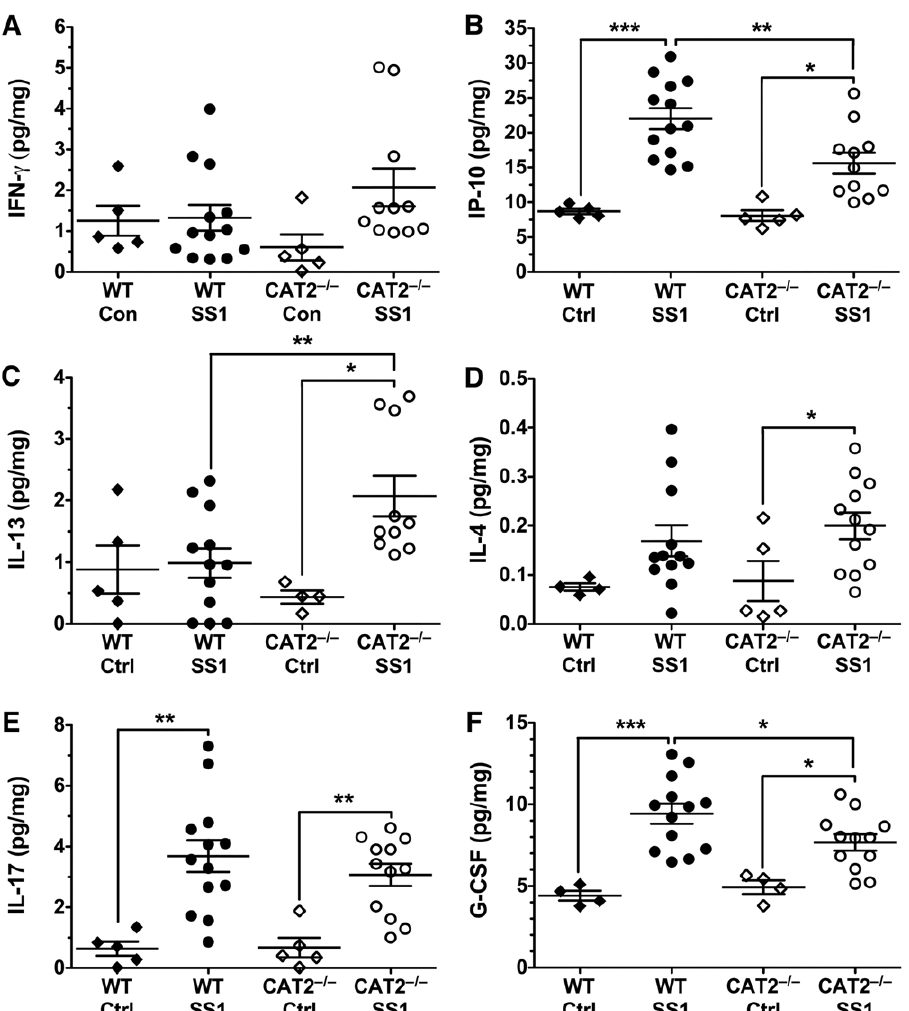
Figure 5. Th2, Th1, and innate response cytokine expression in response to H.pylori infection is altered in CAT2 2 / 2 mice. Protein lysates were analyzed by Luminex for expression levels of other cytokines. (A) IFN- c levels. (B) IP-10 levels. (C) IL-13 levels. (D) IL-4 levels. (E) IL-17 levels. (F) G-CSF levels. Each point represents a single mouse ( n =4–12 per group). *, p , 0.05; **, p , 0.01; ***, p , 0.001 for comparisons indicated.